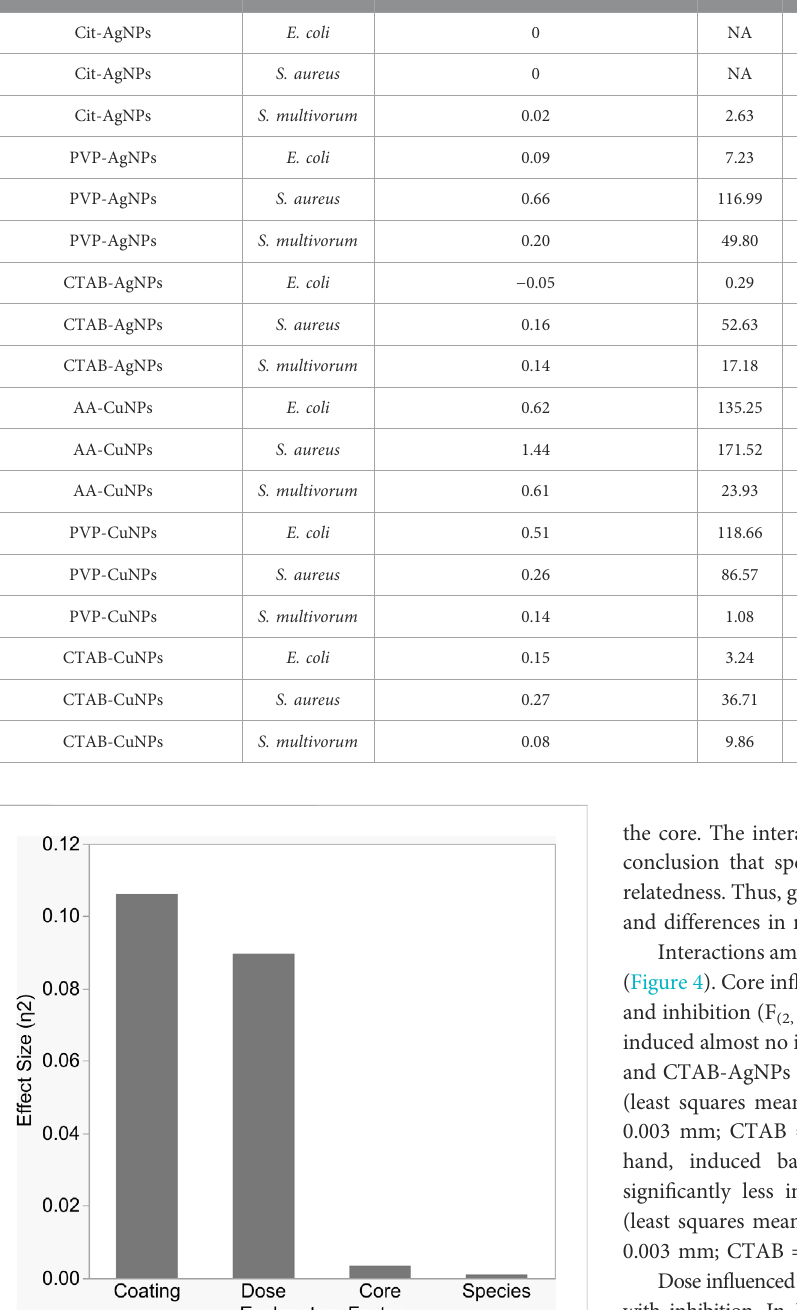
TABLE 1 Summary of regression analyses of dose and inhibition (Figure 2C) for each species and each nanoparticle. The table provides values indicating antibacterialef fi cacypersurfacecoatingthatmaybeusedfortwodifferenttypesofstrategies.Foronestrategy,ifcompleteinhibitionisrequired,theselectionof CTAB-AgNPs would be ideal. For a second strategy, when increased inhibition over increasing dose is desired, then PVP-AgNPs, AA-CuNPs, PVP-CuNPs, or CTAB- CuNPs are ideal. On the other hand, Cit-AgNPs are ineffective in antibacterial ef fi cacy based on the experiments used in these systematic studies. Nanoparticle exposure